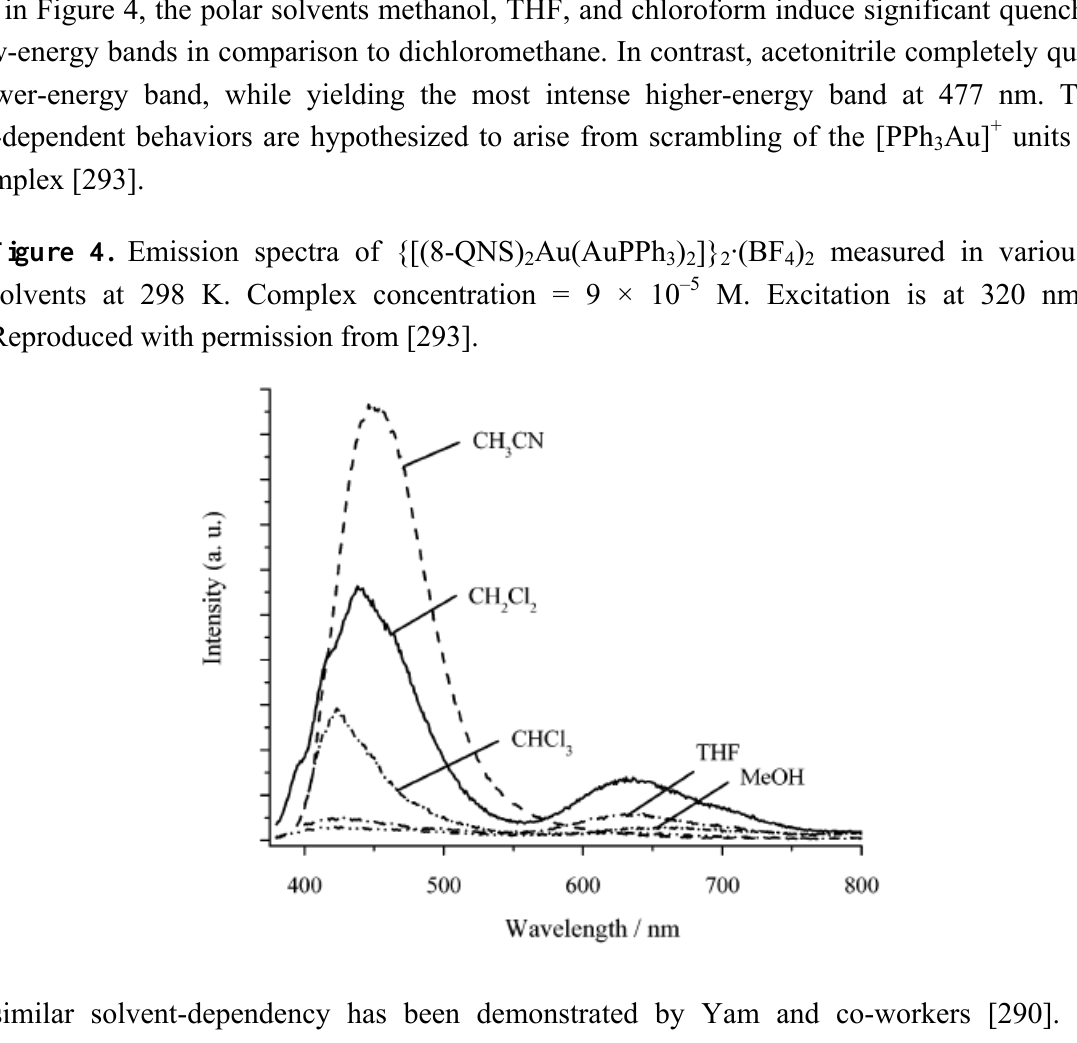
Au(AuPPh ) ]} ·(BF ) measured in various 2 3 2 2 4 2